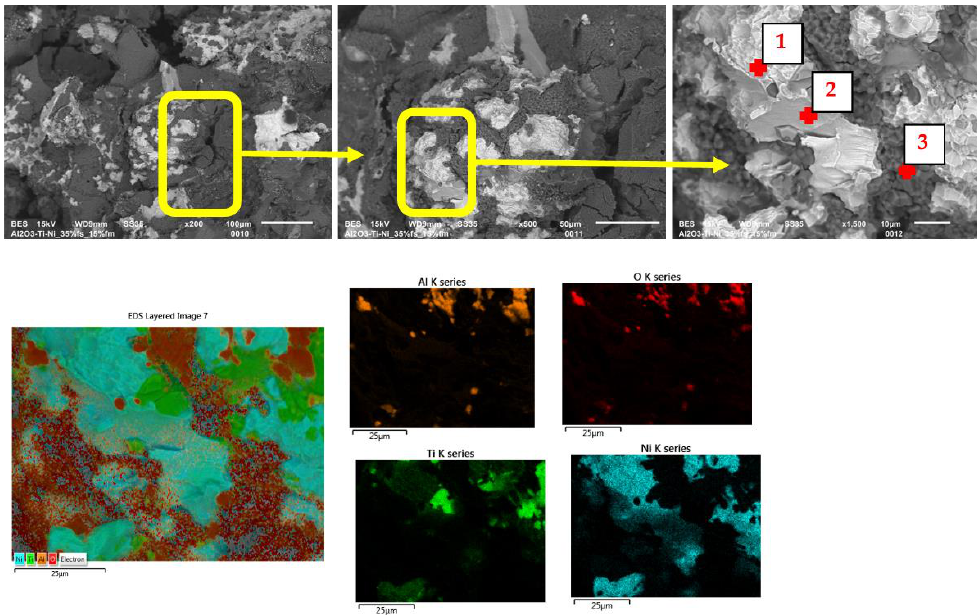
Figure 9. SEM/EDS results of samples with 5% volume of the metallic phase.